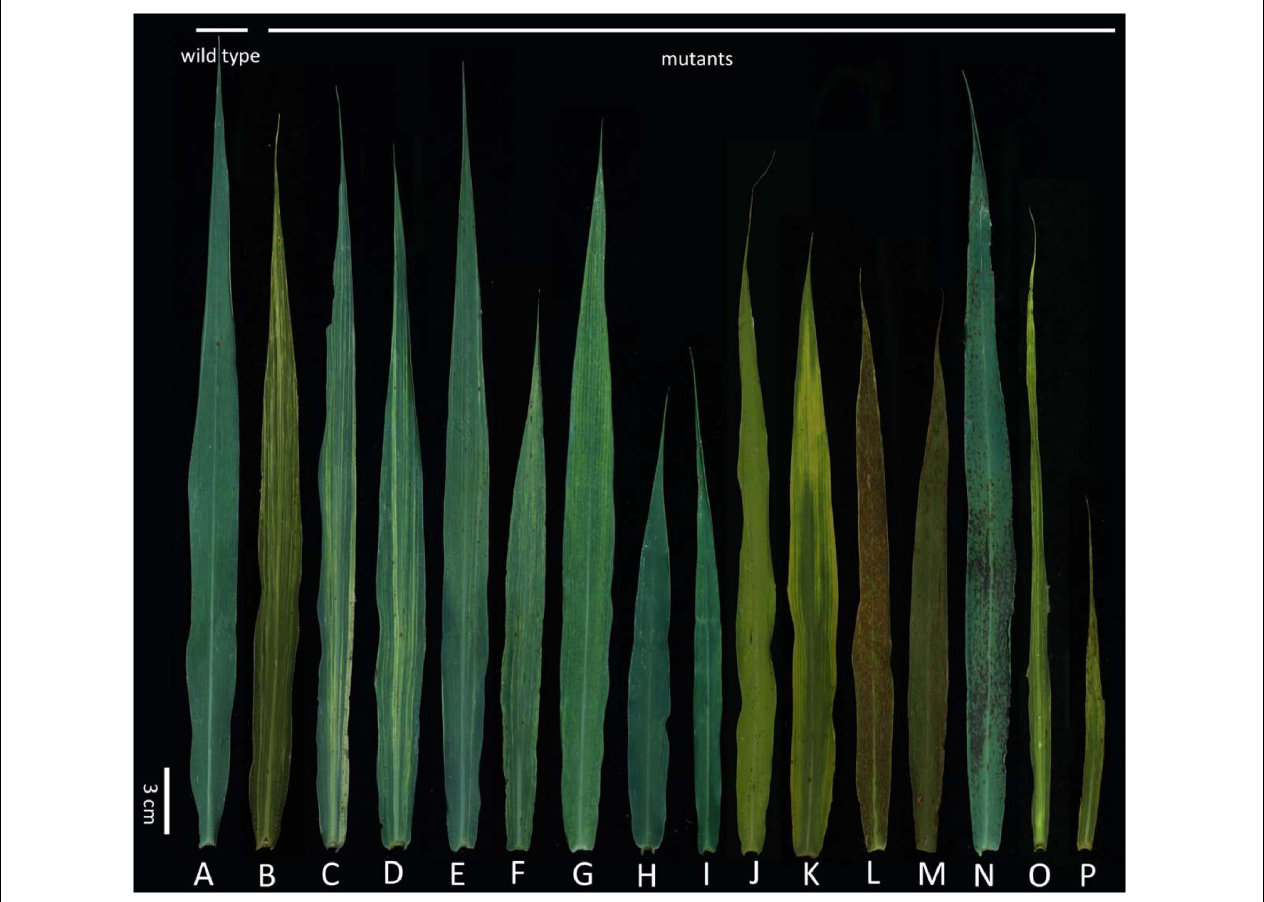
FIGURE 1 | Flag leaf of diverse mutants. (A) Wild-type Yugu1; (B–P) examples of leaf mutants; (B) light white striped; (C–D) white striped; (E) yellowish striped; (F) yellow striped; (G) yellowish striped; (H,I) abnormal leaf shape; (J,K) yellow leaf; (L-N) disease-spot leaf; (O–P) abnormal leaf striped and shape. Scale: 3 cm.